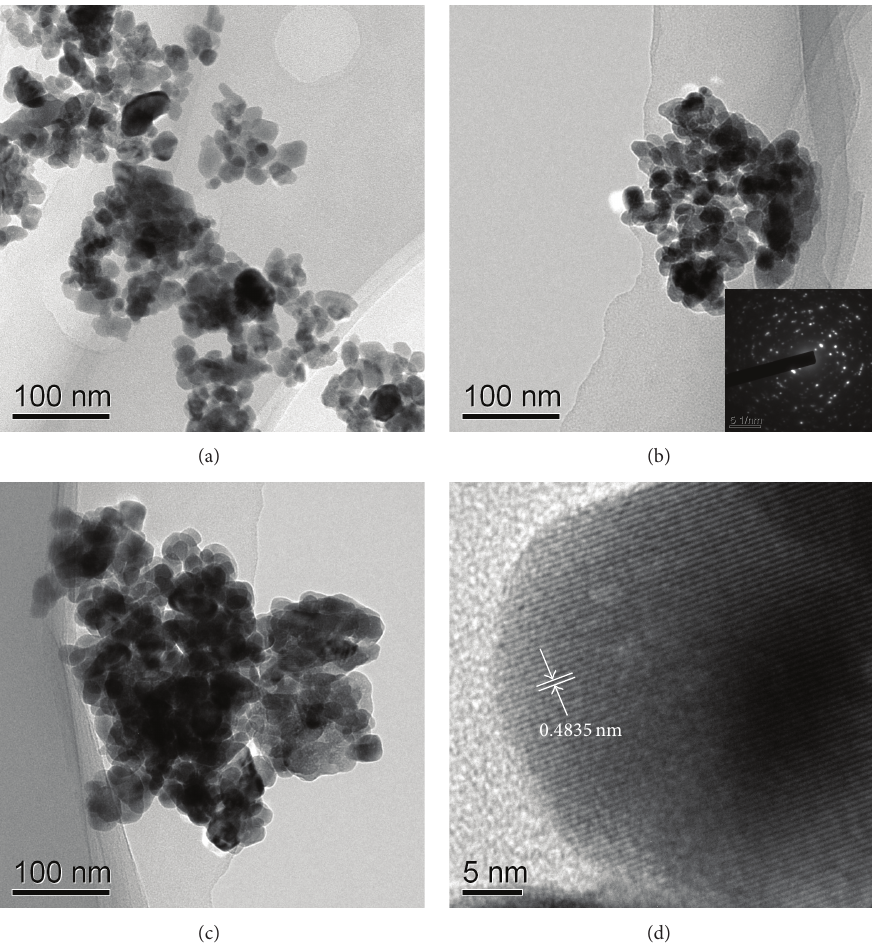
Figure 3: TEM images of the as-prepared CaWO 4 samples synthesized at 120 ∘ C for different reaction times: (a) 5min, (b) 10min, and (c) 15min. (d) A typical higher magnification TEM image of the obtained CaWO 4